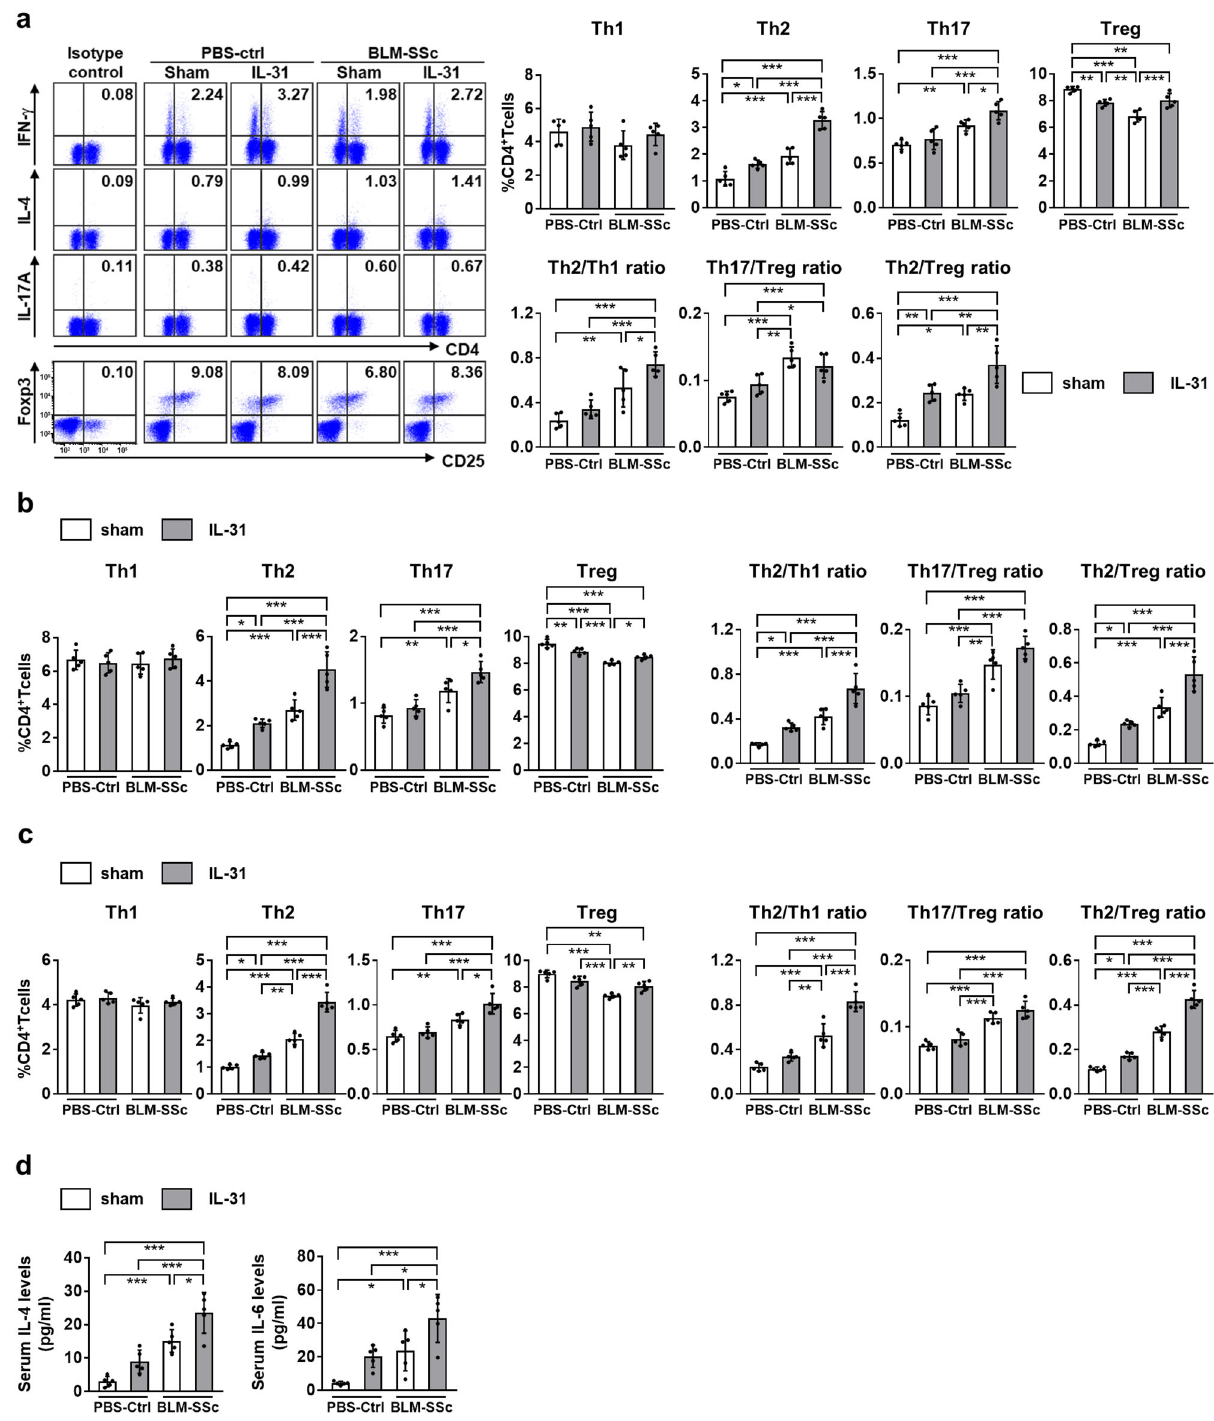
Mice and experimental protocol . Wild-type C57BL/6 mice were purchased from The Jackson Laboratory (Bar Harbor, ME, USA) and housed under controlled temperature (21 ± 1 ˚ C) and relative humidity (60 ±10%) with a 12/12 h dark/light cycle. BLM (Nippon Kayaku, Tokyo, Japan) was dissolved in PBS at a con- centration of 1mg/ml. To generate BLM-SSc mice, BLM was injected at a dose of 200 μ g subcutaneously into the shaved backs of female mice with a 26-gauge needle daily 50 . The mice treated with PBS instead of BLM were used as controls for BLM- SSc mice. To evaluate the effects of IL-31 on BLM-SSc mice, rmIL-31 (200ng; Abcam, Cambridge, MA, USA) and BLM was injected subcutaneously daily for 2 weeks (day 1 to day 14). Saline was used as a sham for rmIL-31. To evaluate